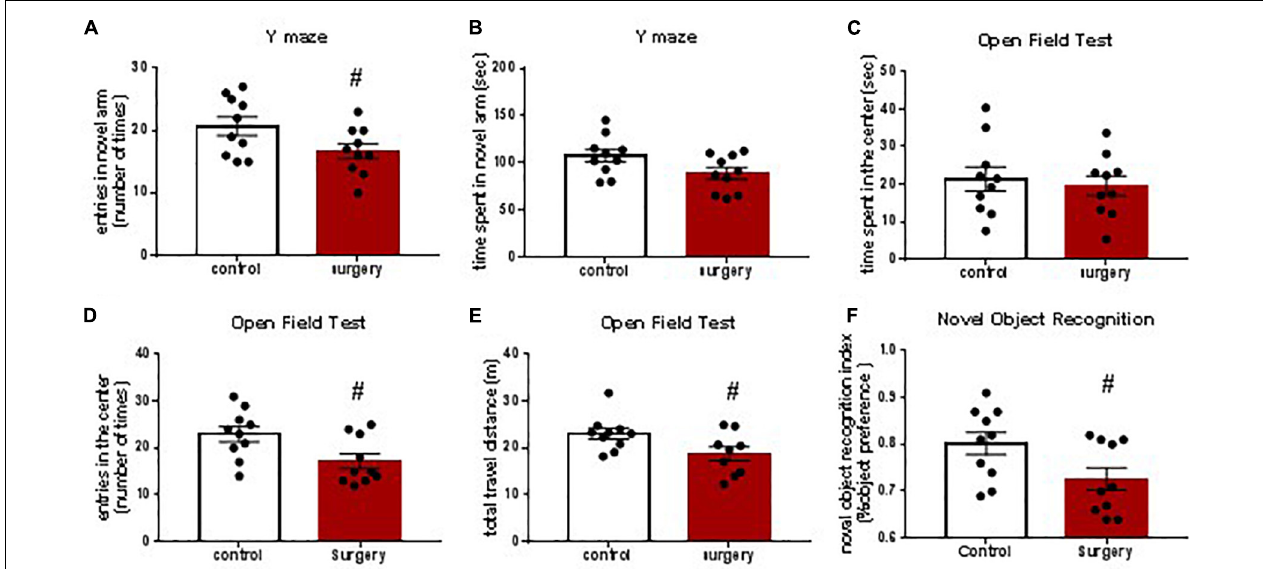
FIGURE 4 | Surgery and anesthesia induced postoperative cognitive dysfunction (POCD)-like behaviors as assessed by Y maze test, open filed test and novel object recognition studies. Y maze was tested 3 days after surgery (A,B) . Open field test was studied 4 days after surgery (C,D,E) . Novel object recognition test was studied 5 and 6 days after surgery. The recognition index was calculated based on the result of the second day of NOR studies (F) . # P < 0.05, n = 10. Results were presented as means ± S.E.M.